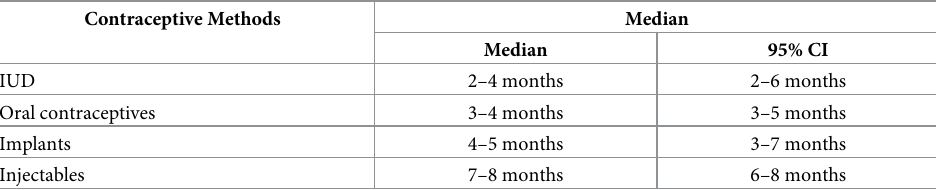
Injectables Source: Calculated by the authors based on Indonesia Demographic and Health Survey 2007, 2012 and 2017 [21, 41,